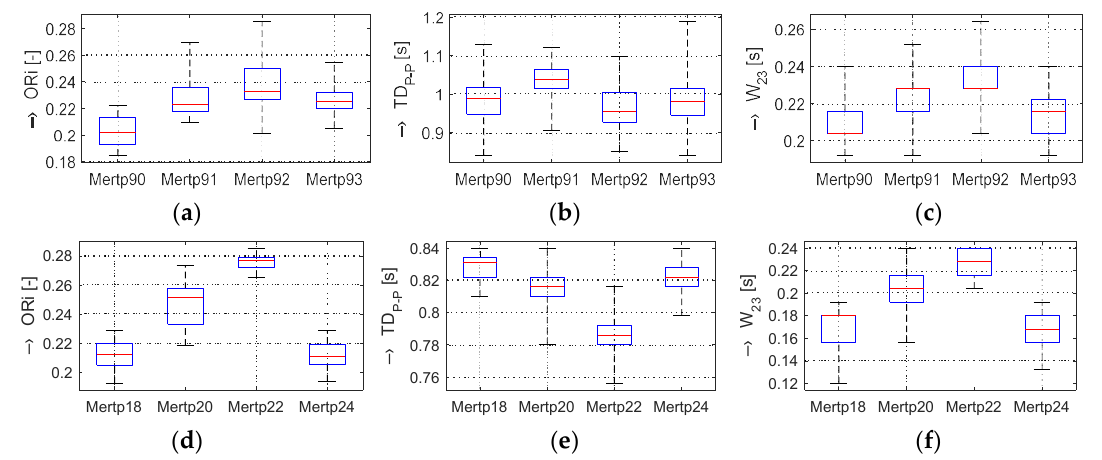
Figure 4. Box-plot of basic statistical parameters of ( a , d ) ORi, ( b , e ) TD P-P , and ( c , f ) W 23 values determined from PPG signals of male (upper set of three graphs) and female (bottom three graphs) persons in Relax (Mertp90,93 + Mertp18,24) and Load (Mertp91,92 + Mertp20,22) phases.